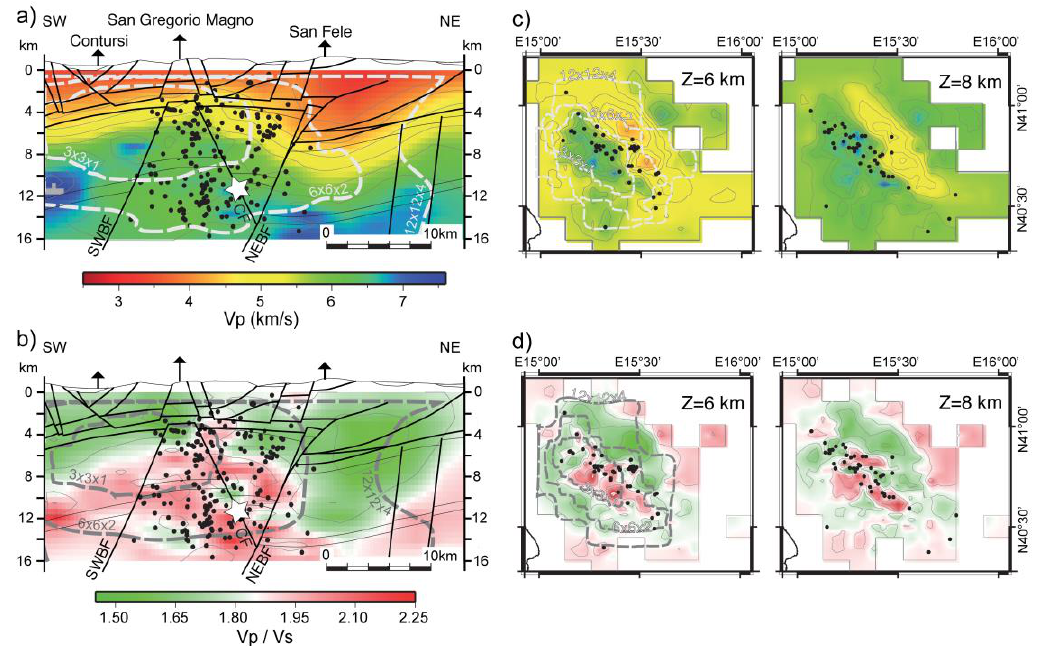
Figure 7. Three-dimensional tomographic model of the 1980 Irpinia earthquake region. ( a ) V P velocity model and microearthquake locations projected onto the cross-section located in Figure 2a (refer to Figure 2b for the tectonic contacts and geological units). Dashed curves delimit the well-resolved regions of the model. Each curve corresponds to a different resolution scale obtained from estimating the resolvability function for each model parametrization used in the multiscale approach, as explained in detail by Amoroso et al. [8]. Star shows the hypocenter of the M S 6.9, 1980 Irpinia earthquake. ( b ) V P / V S ratio for the same depth section as in (a). ( c ) Horizontal slice through the P-wave tomographic model at depths (Z) of 6 km and 8 km. ( d ) Horizontal slice showing V P / V S ratio at depths (Z) of 6 km and 8 km (modified from Amoroso et al. [8]).